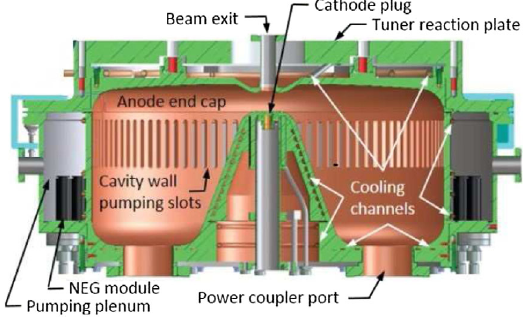
FIG. 1. A CAD cross section of the existing APEX VHF gun.